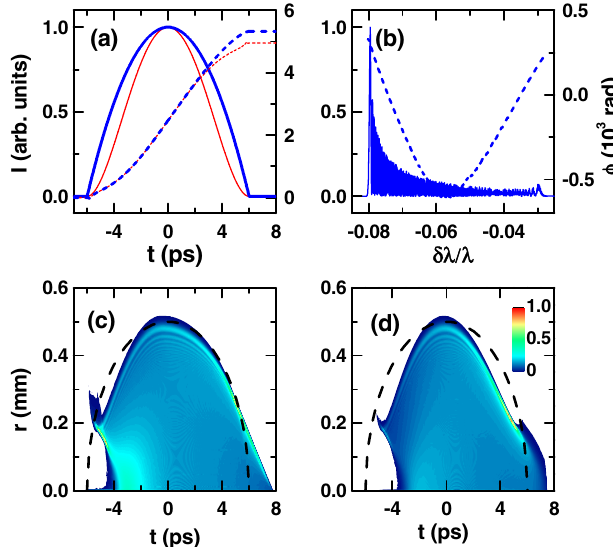
FIG. 1. (Color) (a) Time and (b) frequency domain representa- tion (heavy solid line: intensity; heavy dashed line: phase), and (c) the spatiotemporal intensity distribution of a laser pulse that gives an excellent emittance [ (cid:6) ¼ 1 = 2 at t < 0 , (cid:6) ¼ 1 at t (cid:8) 0 , and (cid:7) ¼ 1 = 2 in Eqs. (4) and (5)]. The pulse has a 5% full bandwidth at 249 nm (about 1% full width at half maximum). The thinner lines in (a) represent a pulse with significant error in amplitude (solid) and phase (dashed) [ (cid:6) ¼ 1 and (cid:7) ¼ 1 in Eqs. (4) and (5)], and (d) is its intensity distribution. A P ¼ 25 mm and f ¼ 150 mm fused silica lens is used. The dashed lines in (c) and (d) are the edge of an ideal ellipsoid. The spatiotemporal distribution in (c) and (d) represents the laser pulses that are to be applied to the